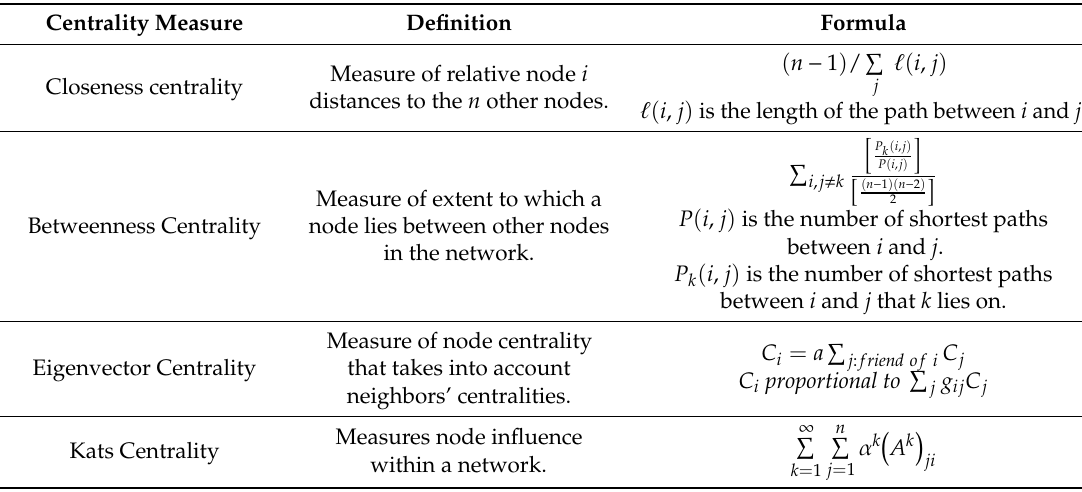
Table 1. Centrality